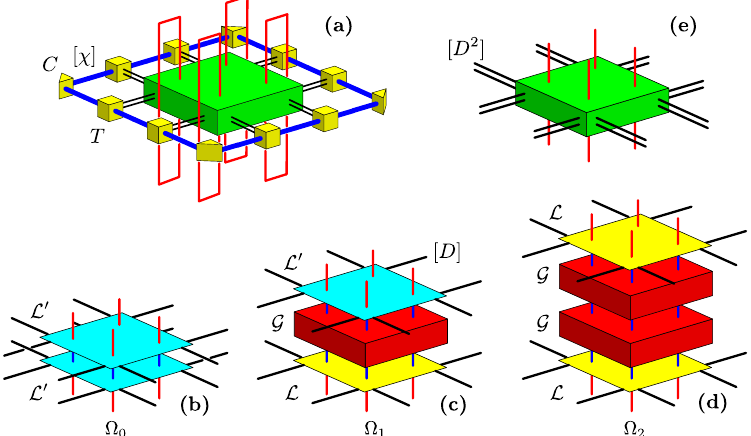
Figure 4: (a) Graphical representation of the overlaps ω using the CTMRG fixed-point environment, and by contracting the operators Ω Ω (c) and Ω (d), respectively, over the ancilla degrees of freedom and drawn in (a) 1 2 using the same generic green box